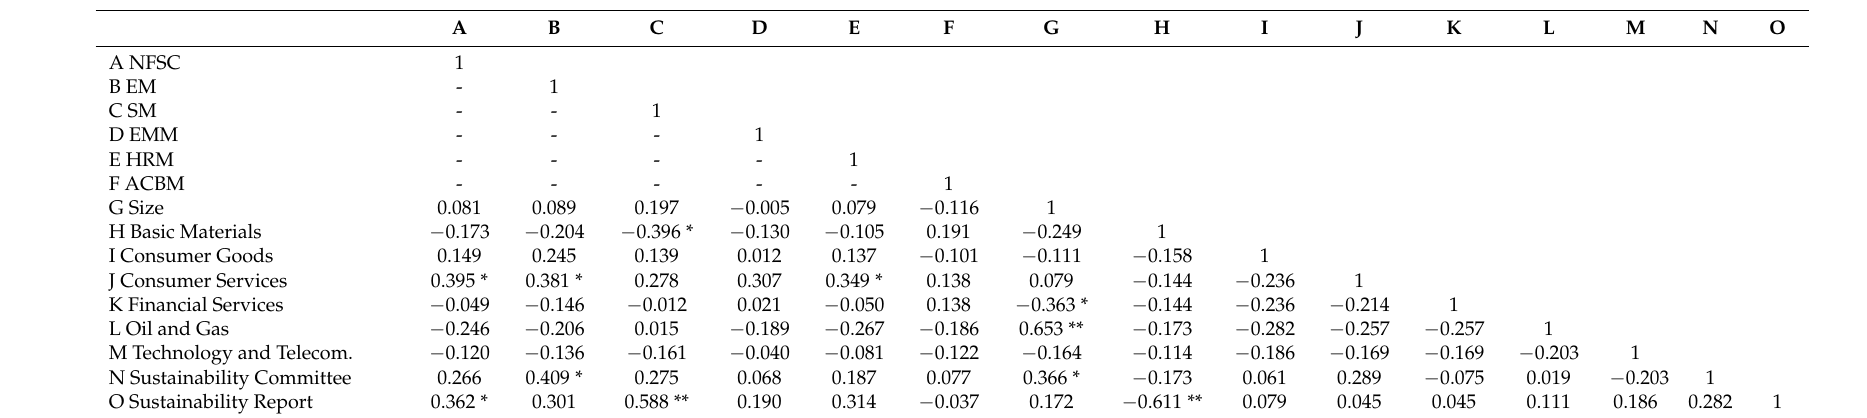
Table 7. Pearson